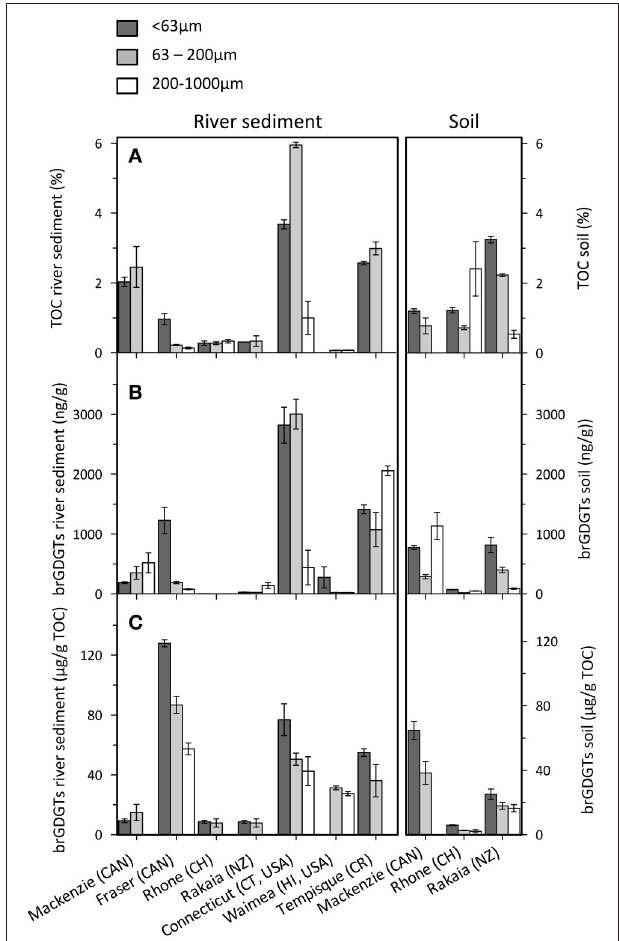
FIGURE 2 | Concentration of (A) TOC, (B) brGDGTs, (C) brGDGTs normalized to TOC in the particle size fractions of riverbank sediments (left panels) and soils (right panels). Error bars represent the variation of triplicate sample